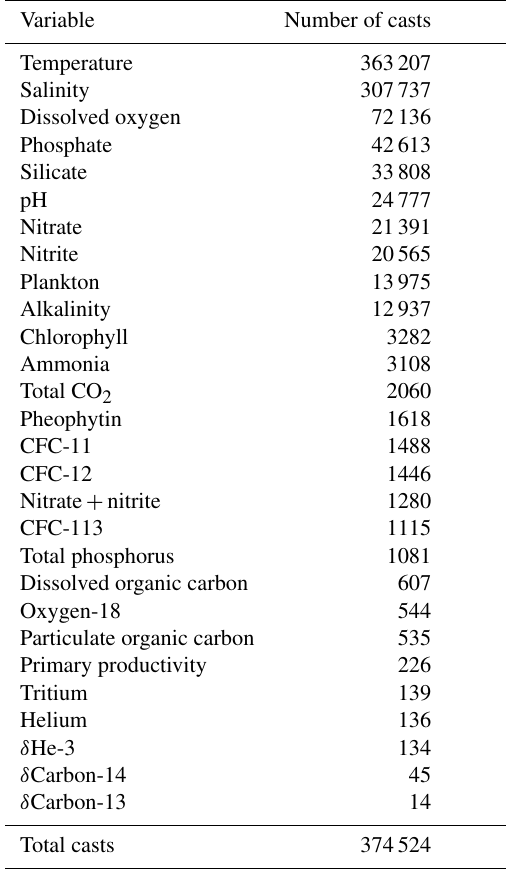
Table 1. Number of Arctic Ocean casts in the bottle (OSD) database that contain each data variable.